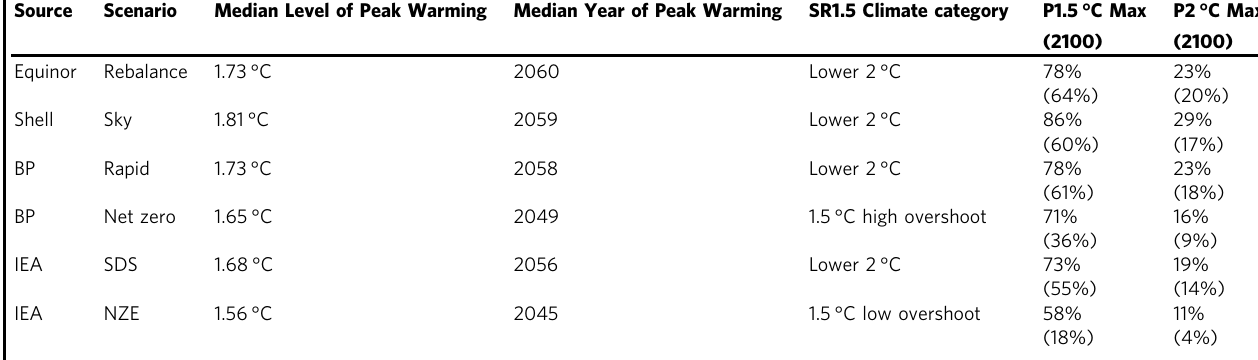
The SR1.5 categories are based on the criteria discussed in the text. The fi nal two columns provide the maximum and end-of-century (in parentheses) exceedance probabilities of 1.5°C and